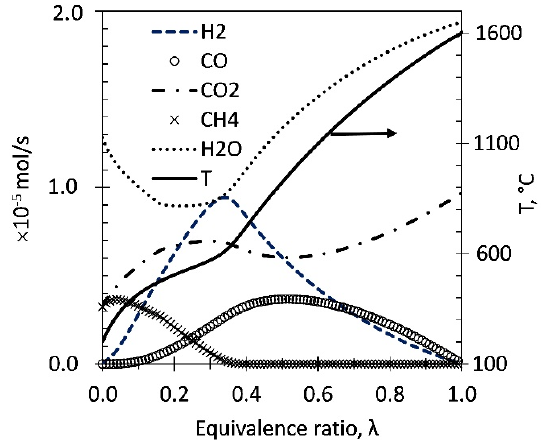
Figure 1. Syngas equilibrium flow composition (mol s − 1 ) and temperature (in ◦ C) obtained at S/C = 2 while varying λ from 0 to 1 for ATR of HAc (feed rate 1 mL/h). HAc is fully converted, hence not shown.